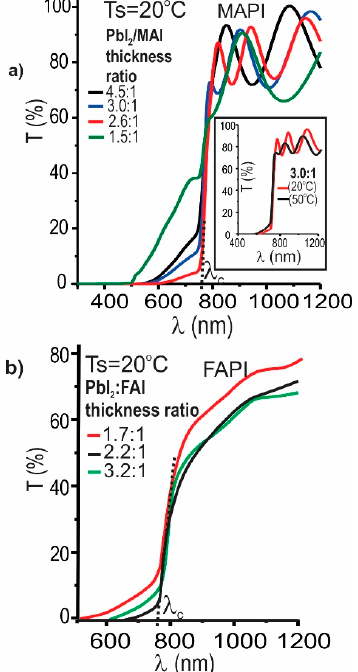
Figure 7. Influence of the PbI 2 / MAI and PbI 2 / FAI thickness ratio on the transmittance spectra of ( a ) MAPI and ( b ) FAPI films prepared at room temperature; in inset are plotted transmittance curves of MAPI films prepared under a thickness ratio of 3:1 and deposited varying the substrate temperature between 20 and 50 ◦